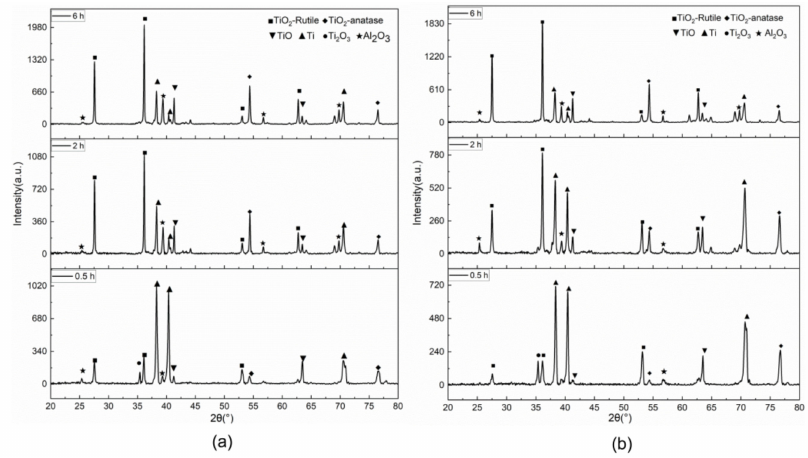
Figure 11. The XPS spectrum at different heating times: ( a ) mechanical grinding, ( b ) laser